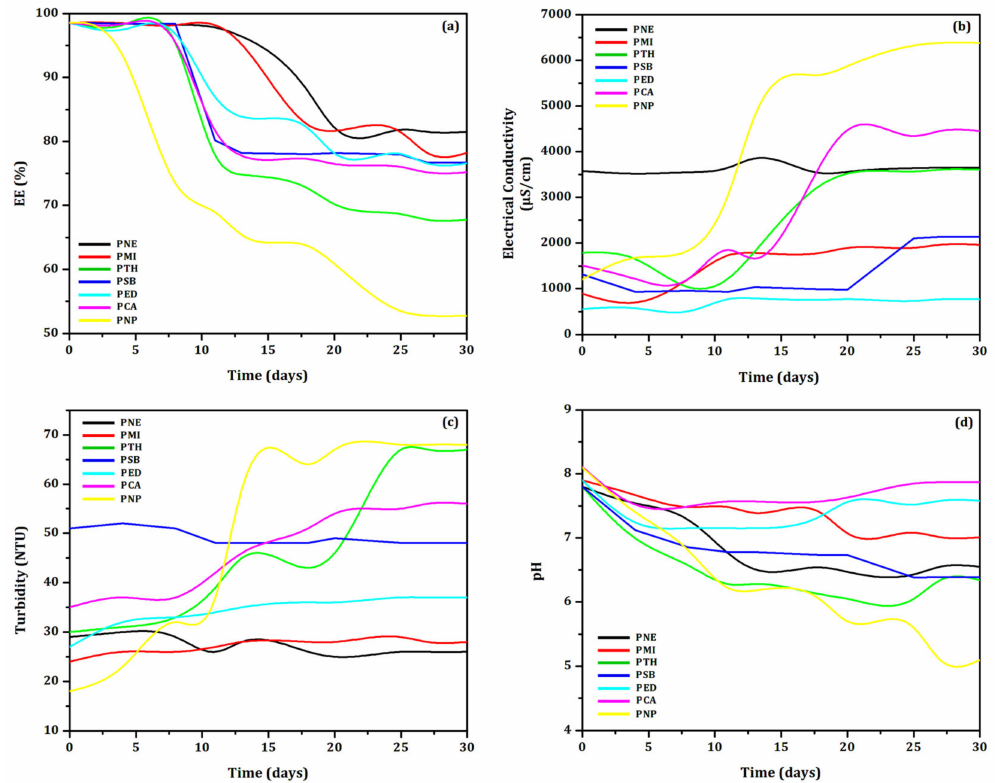
Figure 1. Evaluation of ( a ) Encapsulation Efficiency (EE%), ( b ) electrical conductivity, ( c ) turbidity and ( d ) pH of all developed biodefensives (PNE, PMI, PTH, PSB, PED, PCA and PNP) for 30